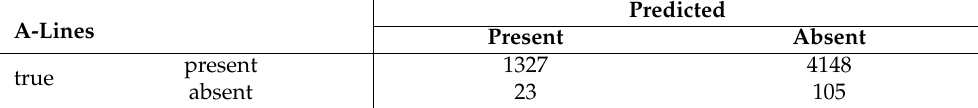
Table 4. Confusion matrix for A-lines.